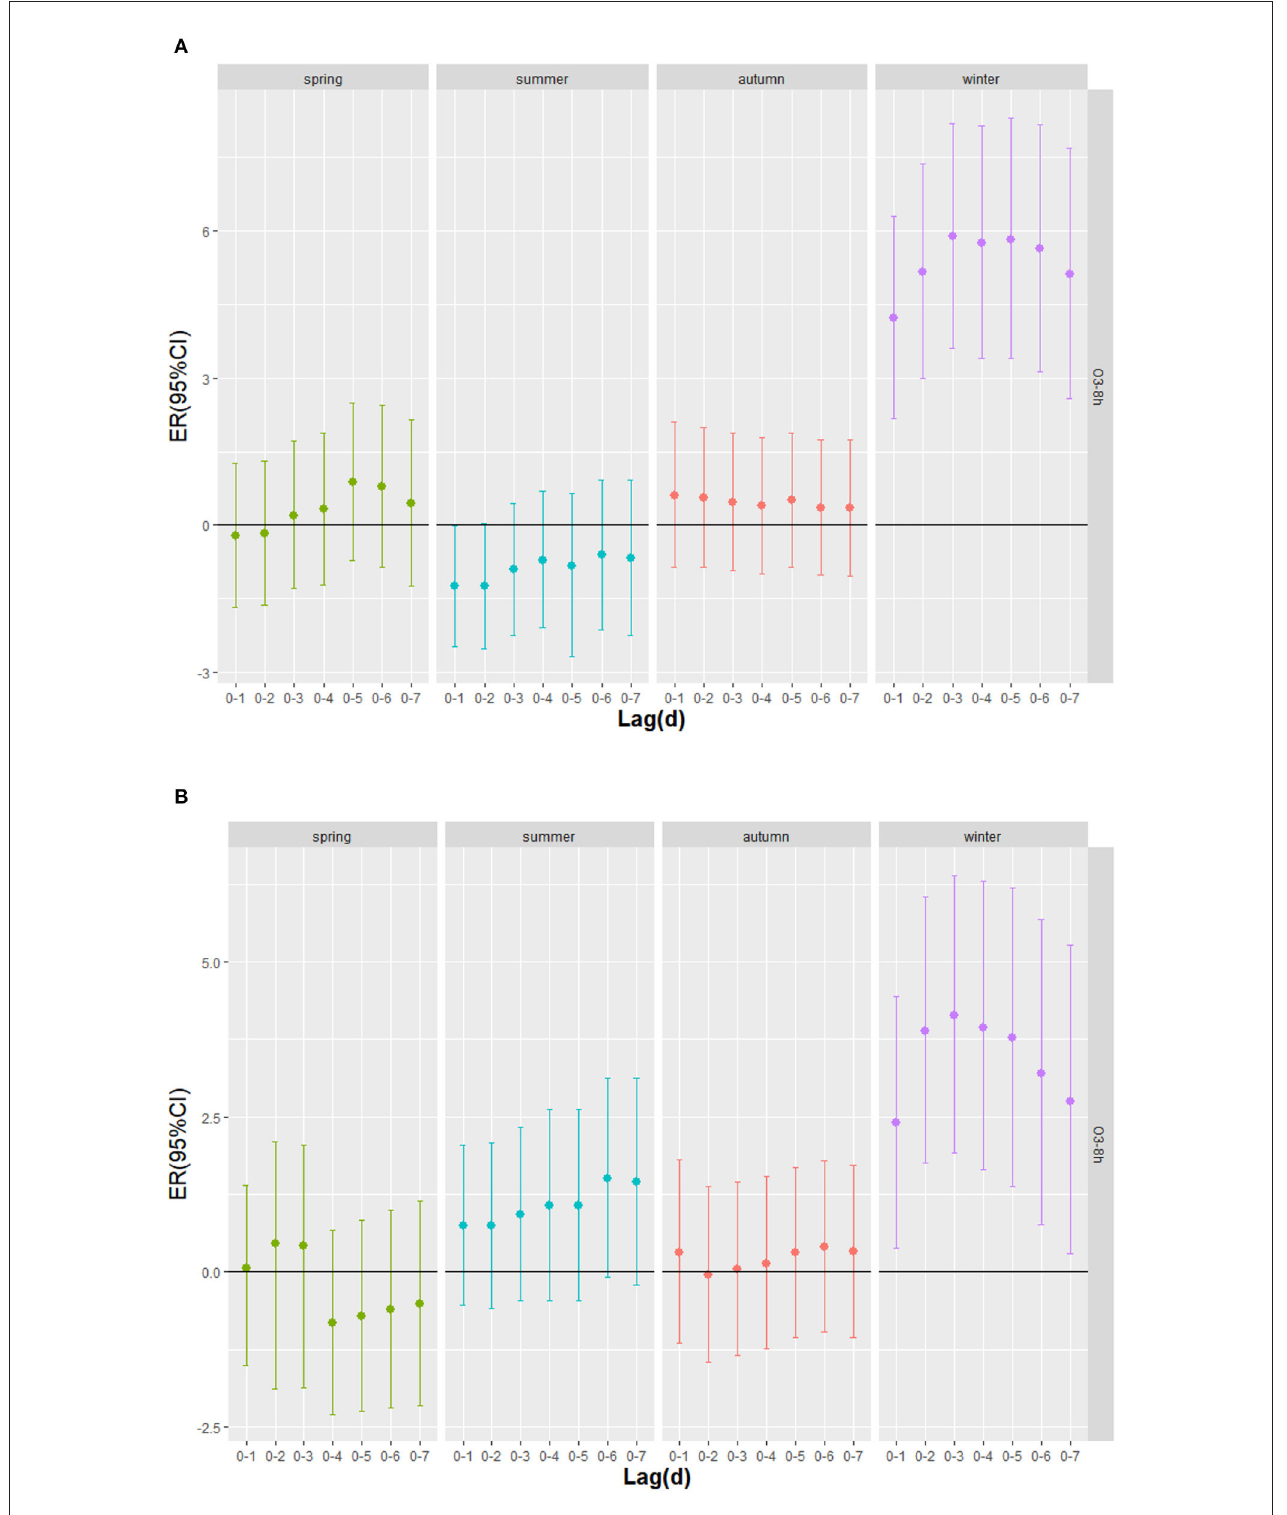
FIGURE 8 | The cumulative excess risk (95%CI) of mortality in season lag-response relationship associated with 10 µ g/m 3 increase of O 3 -8h concentration; (A) O 3 -8h lead to respiratory mortality; (B) O 3 -8h lead to cardiovascular mortality.